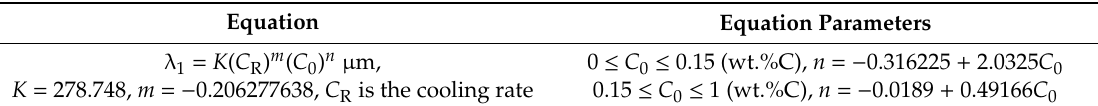
Table 2. Expression to the primary dendrite arm spacing ( λ 1 ). Equation Parameters